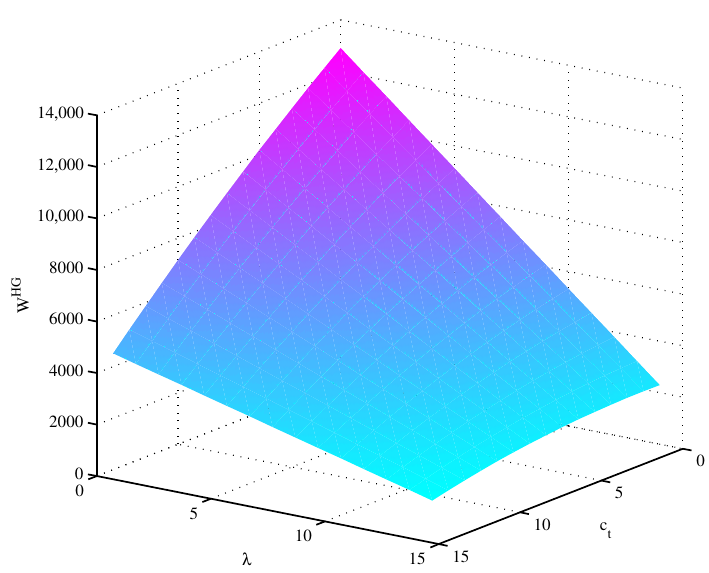
Figure 2. Effects of c t and λ on W HG . Table 6. Comparison of four